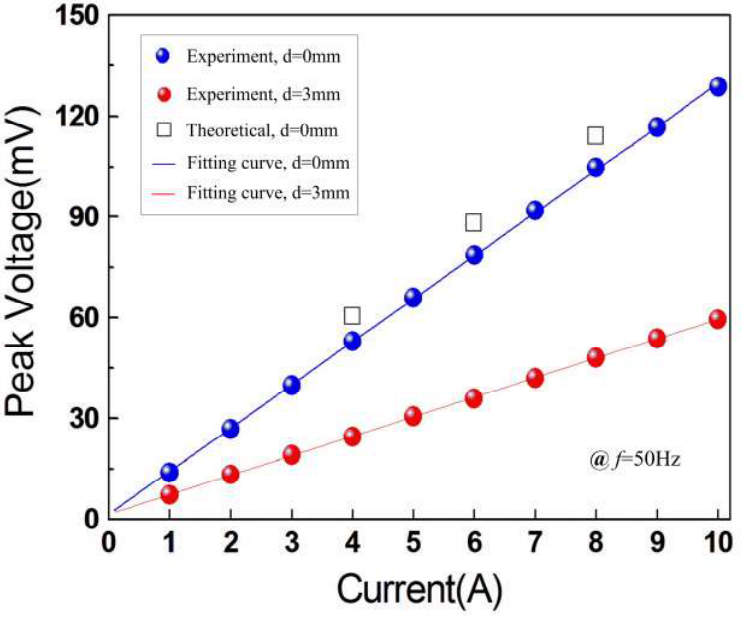
Figure 4. Induced voltage versus the electric current for d = 0 mm and d = 3 mm.